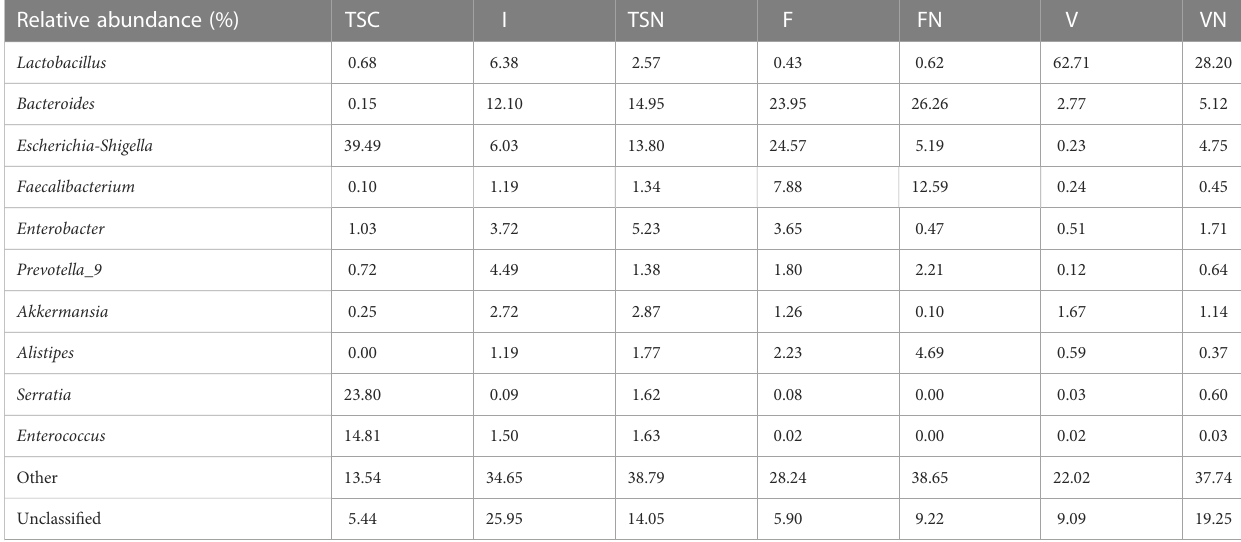
TABLE 3 Relative abundance at the genus level.